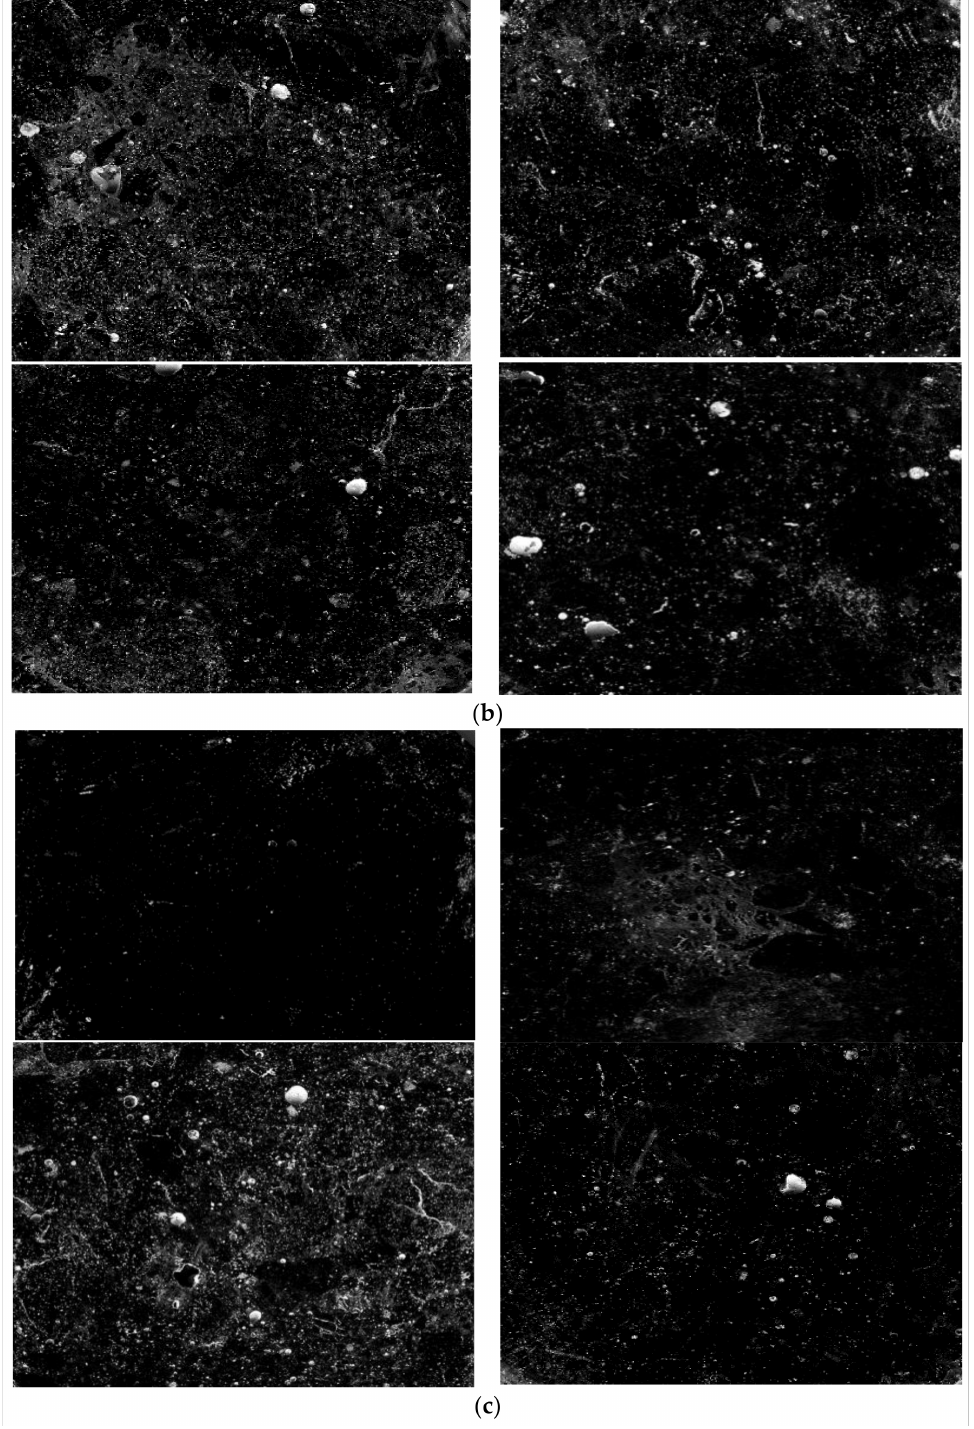
Figure 7. The prepared concrete cut plane samples for air void parameters test. ( a ) 15% moisture content concrete cut plane sample (Group A); ( b ) 8% moisture content concrete cut plane sample (Group B); ( c ) 4% moisture content concrete cut plane sample (Group